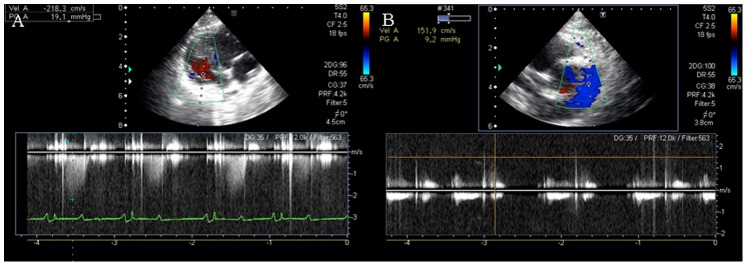
Measurements of the velocity and pressure gradient of the tricuspid regurgitation (Panel A) and pulmonary valve regurgitation (Panel B) using continuous-wave Doppler in a minipig at 6 weeks after placebo injection in the control group.